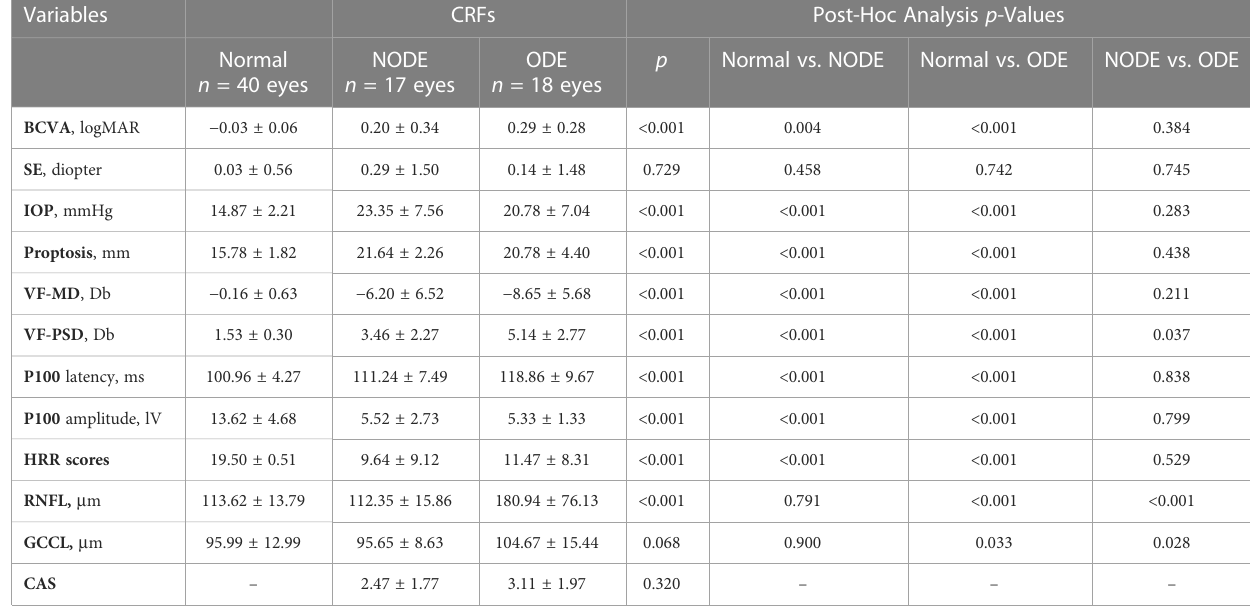
Data are shown as the mean ± SD.